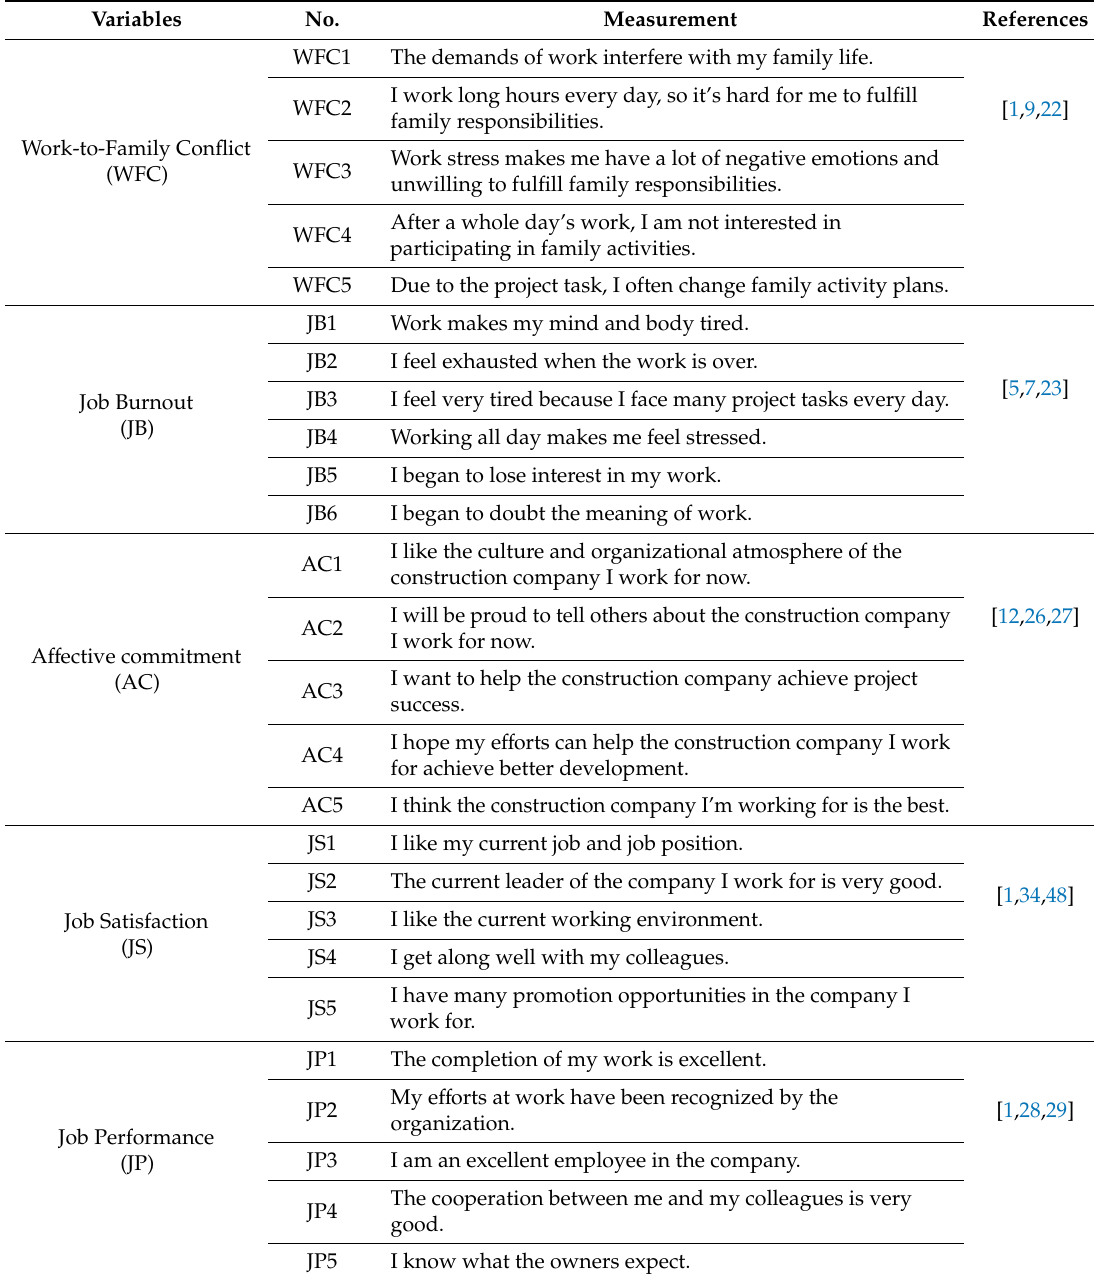
Table 1. Measurements for